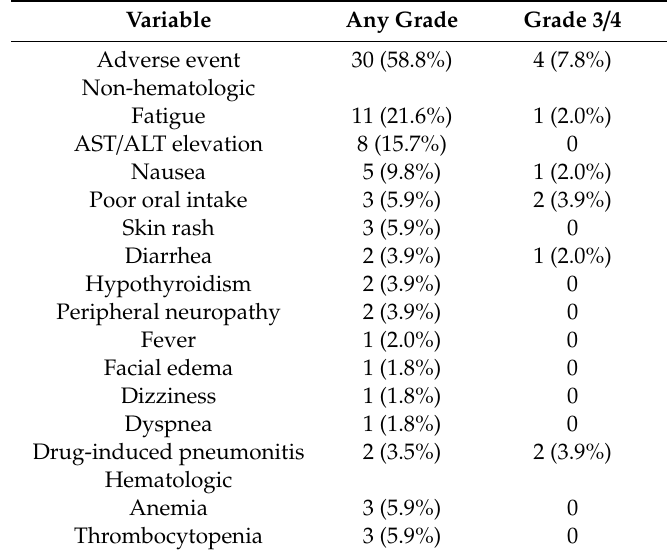
Table 3. Adverse events (AEs).